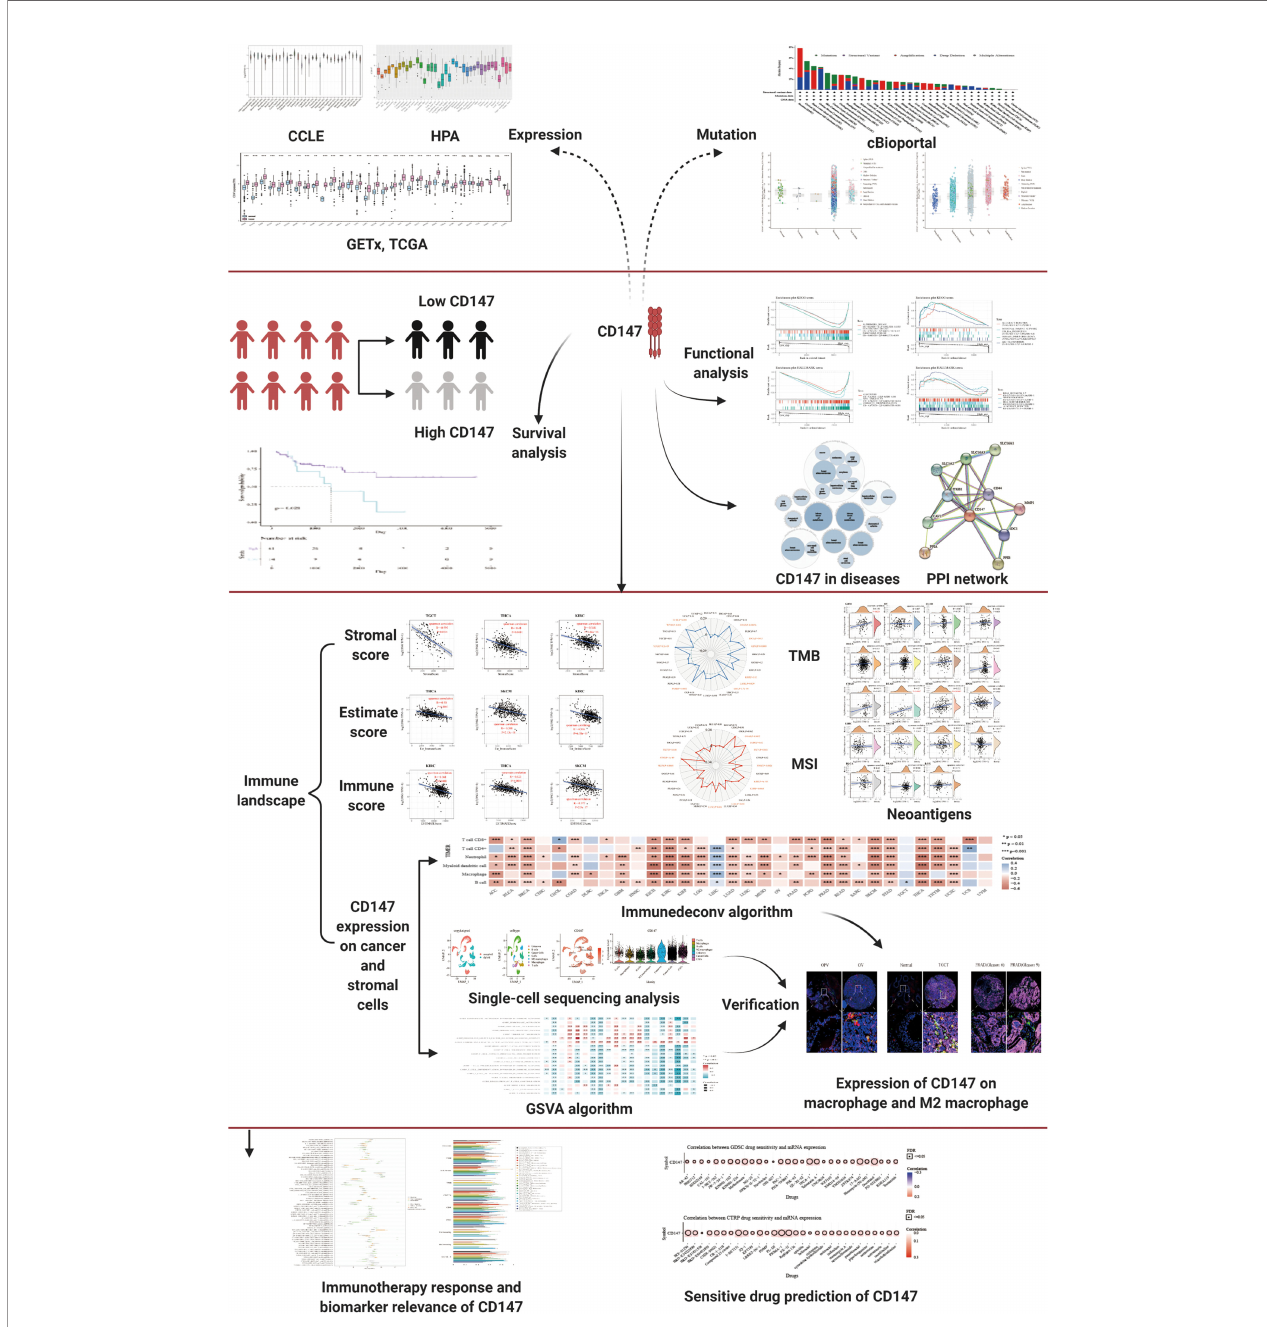
FIGURE 1 | The fl ow chart of the entire